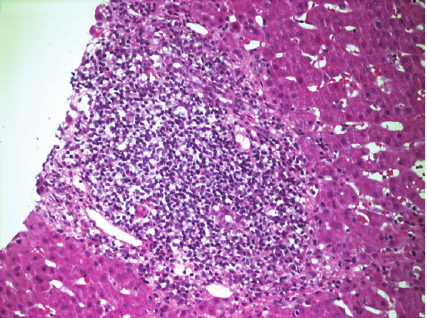
Figure 2: Liver biopsy showing a portal tract containing a dense, predominantly lymphocytic infiltrate. There is minimal inflamma- tion affecting the peripheral interface region of the portal tract. The portal vein, hepatic artery, and several biliary structures can be seen within the infiltrate (haematoxylin and eosin stain, magnification ×